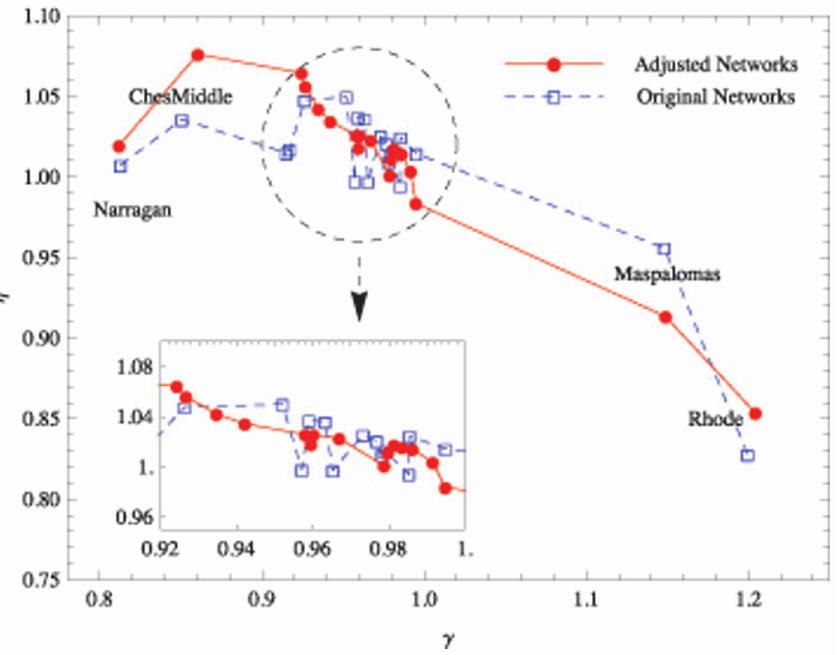
Figure 3. The relationship between c and g in the original and adjusted ecological flow networks .The blue dashed line is the c { g curve for the original flow networks, and the solid red line is the corresponding curve for the adjusted networks based on the same network structure and dissipation law according to the flow adjusting algorithm (see the main text).